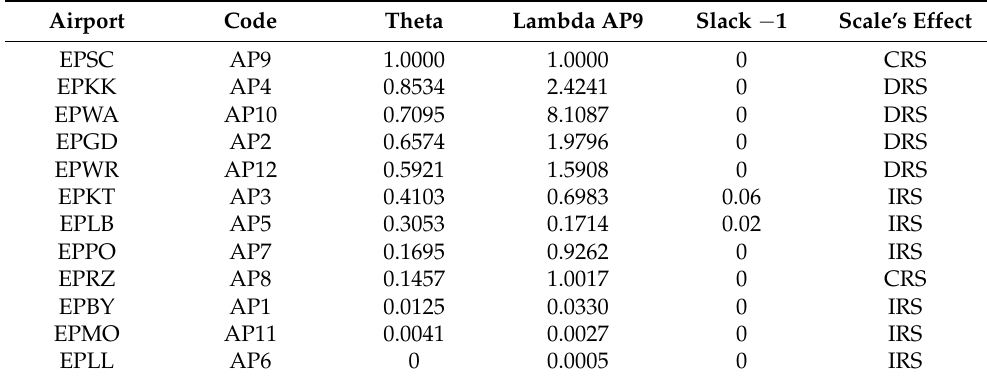
Table 4. DEA results for Polish